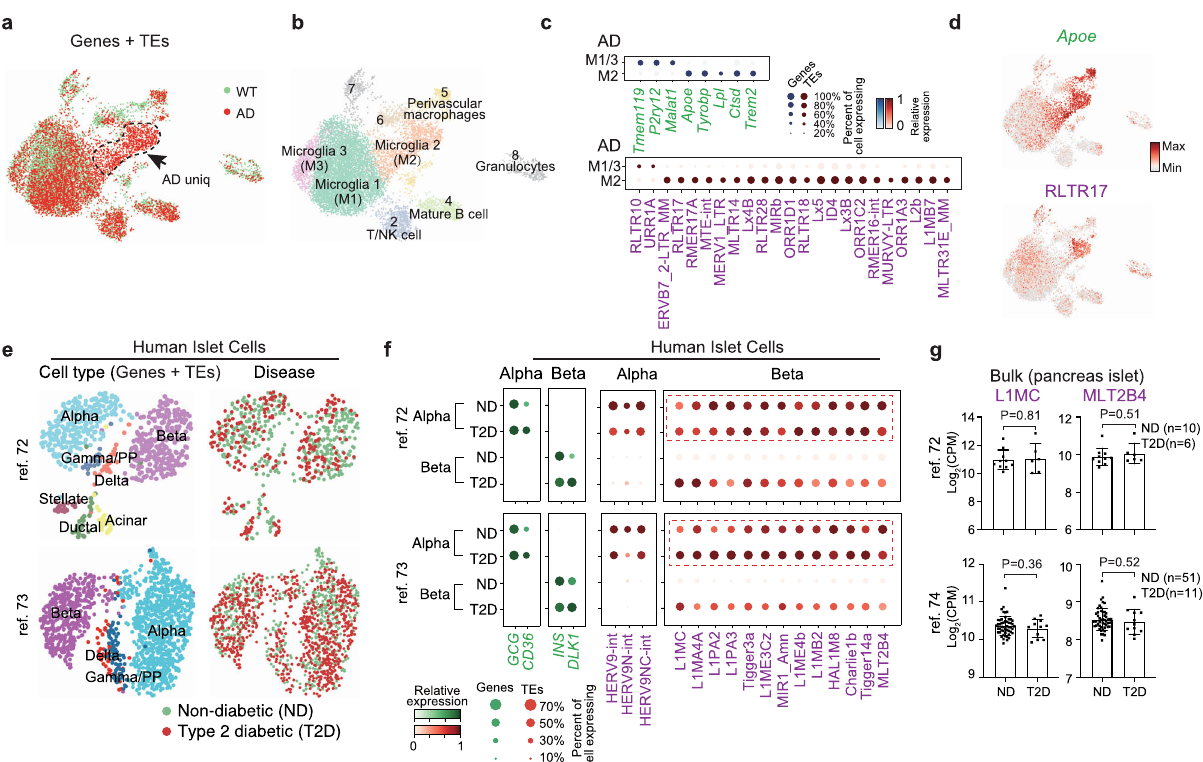
Fig. 7 TEs are differentially expressed in single cells in the diseased state. a UMAP plot of the single cells genes and TE expression, cells are colored by WT (wild-type) and AD (Alzheimer ’ s disease) state. b UMAP plot, as in ( a ), but clustered into groups (Leiden, resolution = 0.5). c Dot plot showing the differential expressed genes (top) and TEs (bottom) between disease-associated microglia (M2) and homeostatic microglia (M1/3) in AD mice. d UMAP plot, as in ( a ), but cells are colored by the expression of the indicated Apoe or the TE RLTR17. e UMAP plots of pancreatic islet cells. Cells are colored by cell types (left) or disease-state (right). Cell types were annotated according to the metadata from the original study, and matched the expression of known marker genes. f Dot plot showing marker gene expression (green) or TEs (red) differentially expressed between healthy and T2D alpha and beta cells (Benjamini – Hochberg corrected Wilcoxon rank-sum test, P < 0.01, and at least >2-fold change between groups). g Bar charts showing the expression of the indicated TEs from bulk RNA-seq data. Data are presented as mean values ± SD. P -value was from an unpaired Student ’ s t